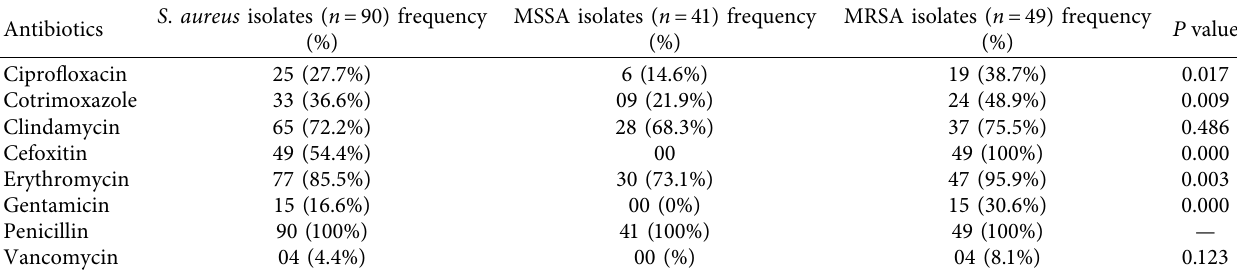
Table 3: Antibiotic resistance patterns of S . aureus , MSSA, and MRSA isolates.